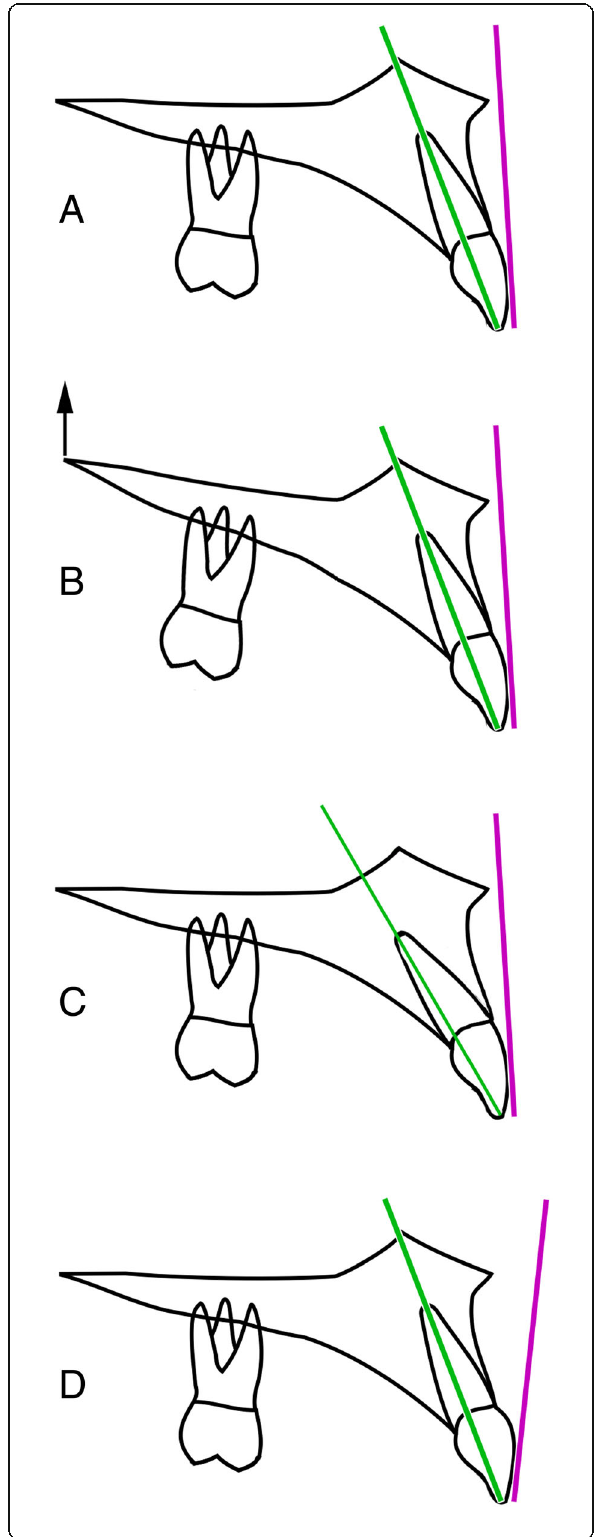
Fig. 1 Potential problems with traditional methods of measuring maxillary incisor inclination. a The maxillary incisor long axis (line drawn from incisor tip through to the apex) and the labial face tangent, drawn as a tangent to the labial face of the maxillary central incisor in profile view. b The inclination of anatomical reference planes is subject to considerable individual variability, e.g. if the maxillary plane is inclined upwards at the back as shown in this diagram, and this would affect the measured incisor long axis inclination in relation to the maxillary plane, but not necessarily the inclination of the maxillary incisor labial face tangent. c There may be variation in the incisor crown-root angle, and, as such, the long axis of the incisor tooth may not match that of the crown. d There may be considerable variation between the inclination of the long axis of the maxillary central incisor and the inclination of a